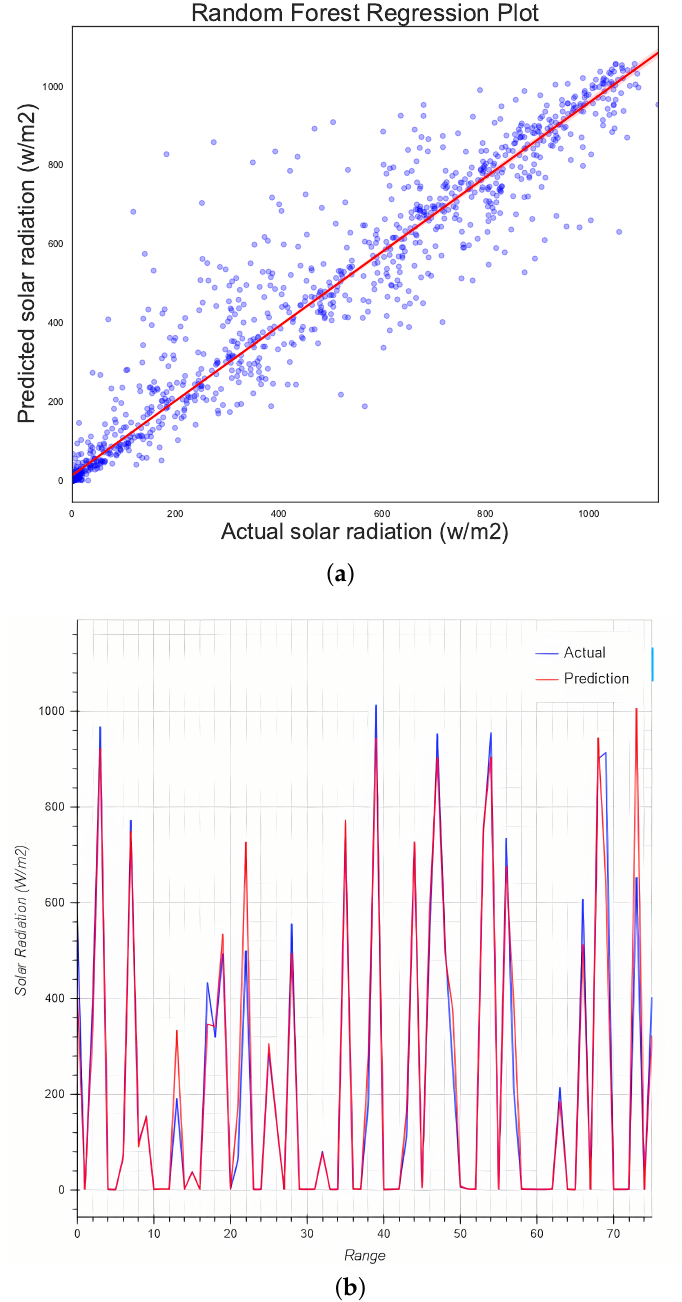
Figure 11. ( a ) Regression plot and ( b ) model validation plot for the RF